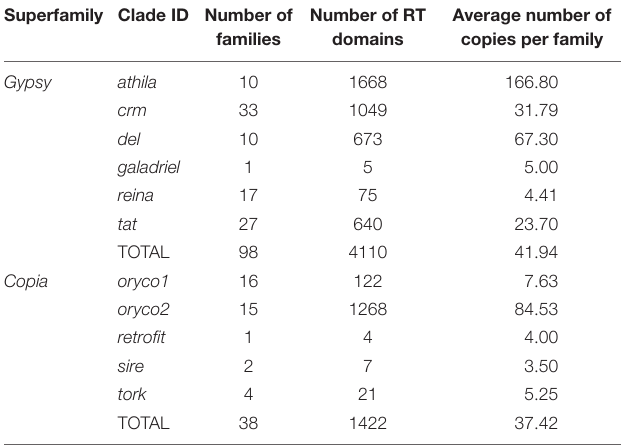
TABLE 2 | Numbers of families of Gypsy and Copia superfamily of LTR-RTs in T. arvense